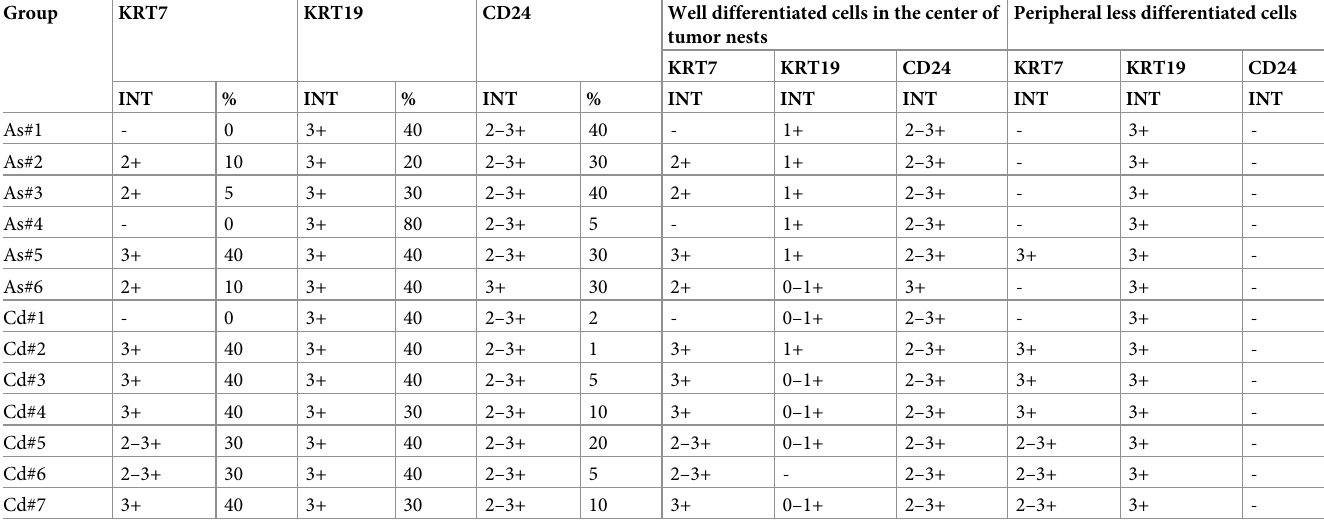
Table 3. Expression and localization of luminal protein markers in different histological areas of the As 3+ and Cd 2+ tumor transplants. Group